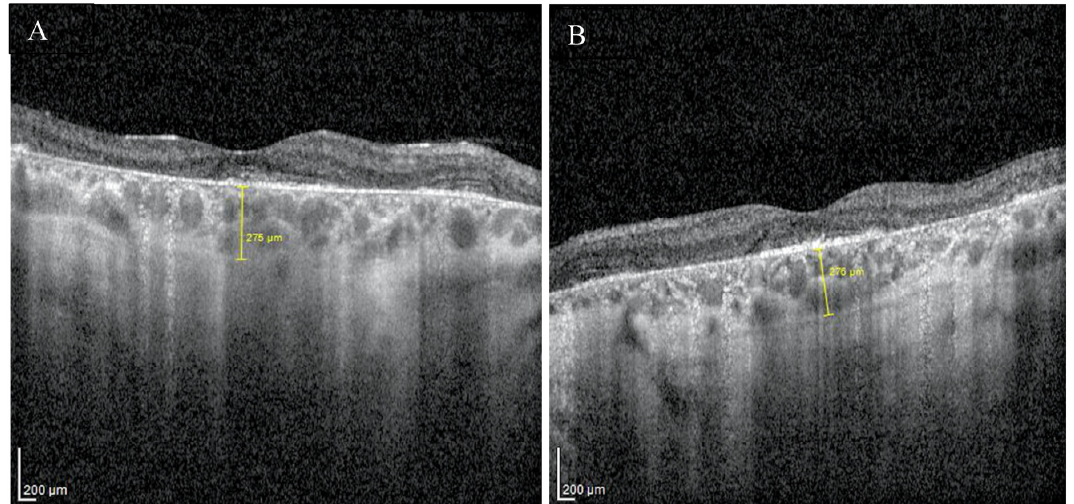
Figure 2. EDI-OCT pictures of the right ( A ) and the left ( B ) macula revealed atrophy of outer layers with normal choroid thickness.